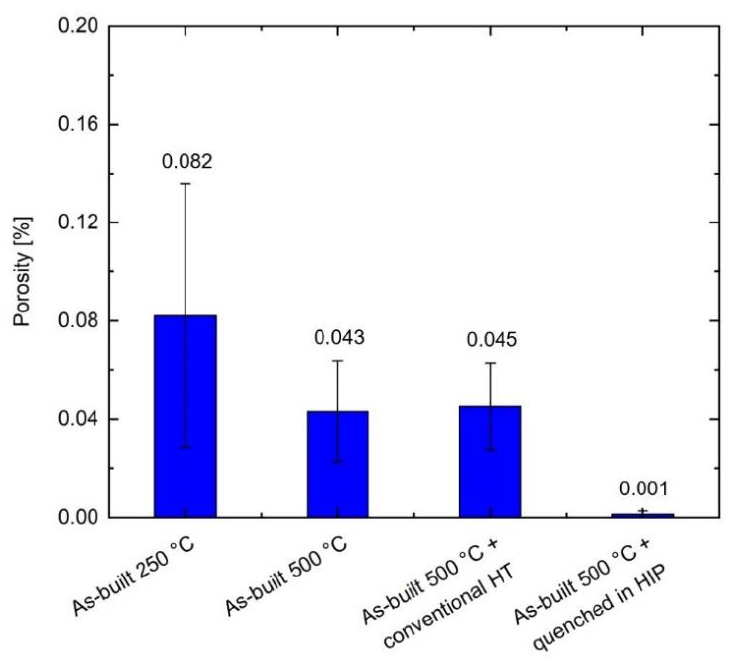
Figure 4. Porosity (middle value and standard deviation) in different conditions. For the two post treatments, samples built with preheating at 500 °C were used.